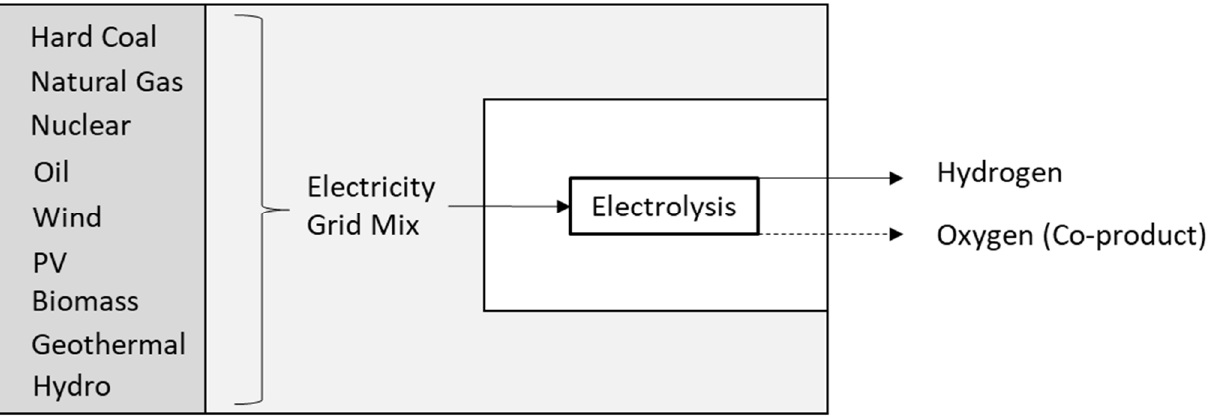
Figure 2. System boundary for hydrogen